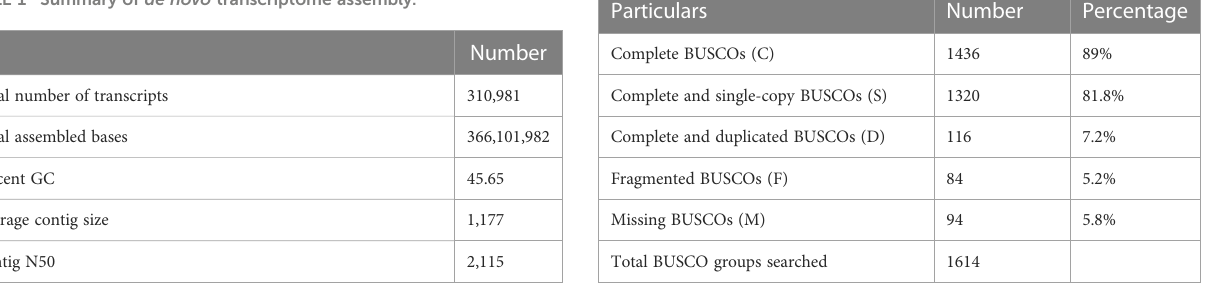
TABLE 1 Summary of de novo transcriptome assembly.